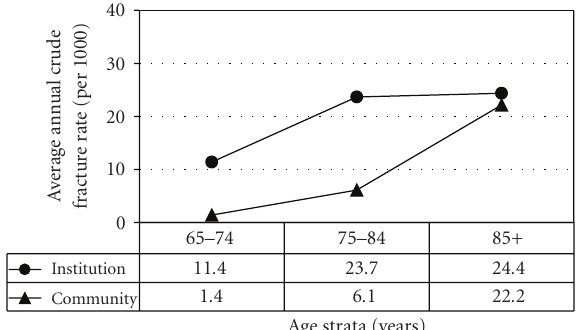
Figure 2: Average annual crude hip fracture rates (person-years) in men by age strata and pre-fracture residence